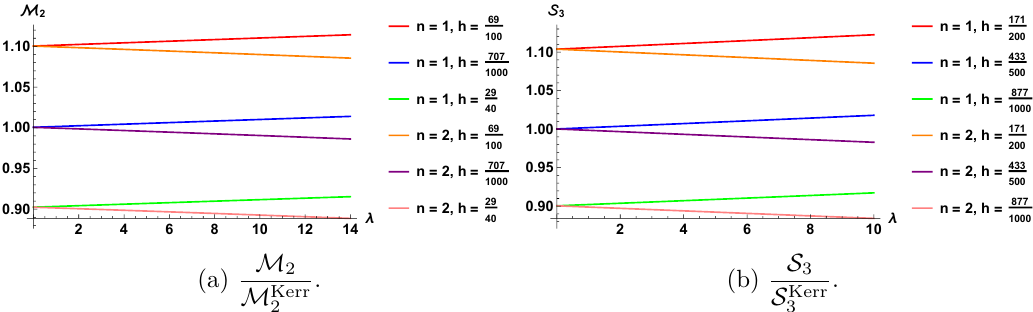
and S (where the corresponding Kerr(-Newman) Figure 2 : Plots of M / M Kerr / S Kerr 2 3 2 3 black hole is chosen to have the same mass and angular momentum as the microstate) as a function of λ for x = 1 and the different values of h and n indicated by the legend.